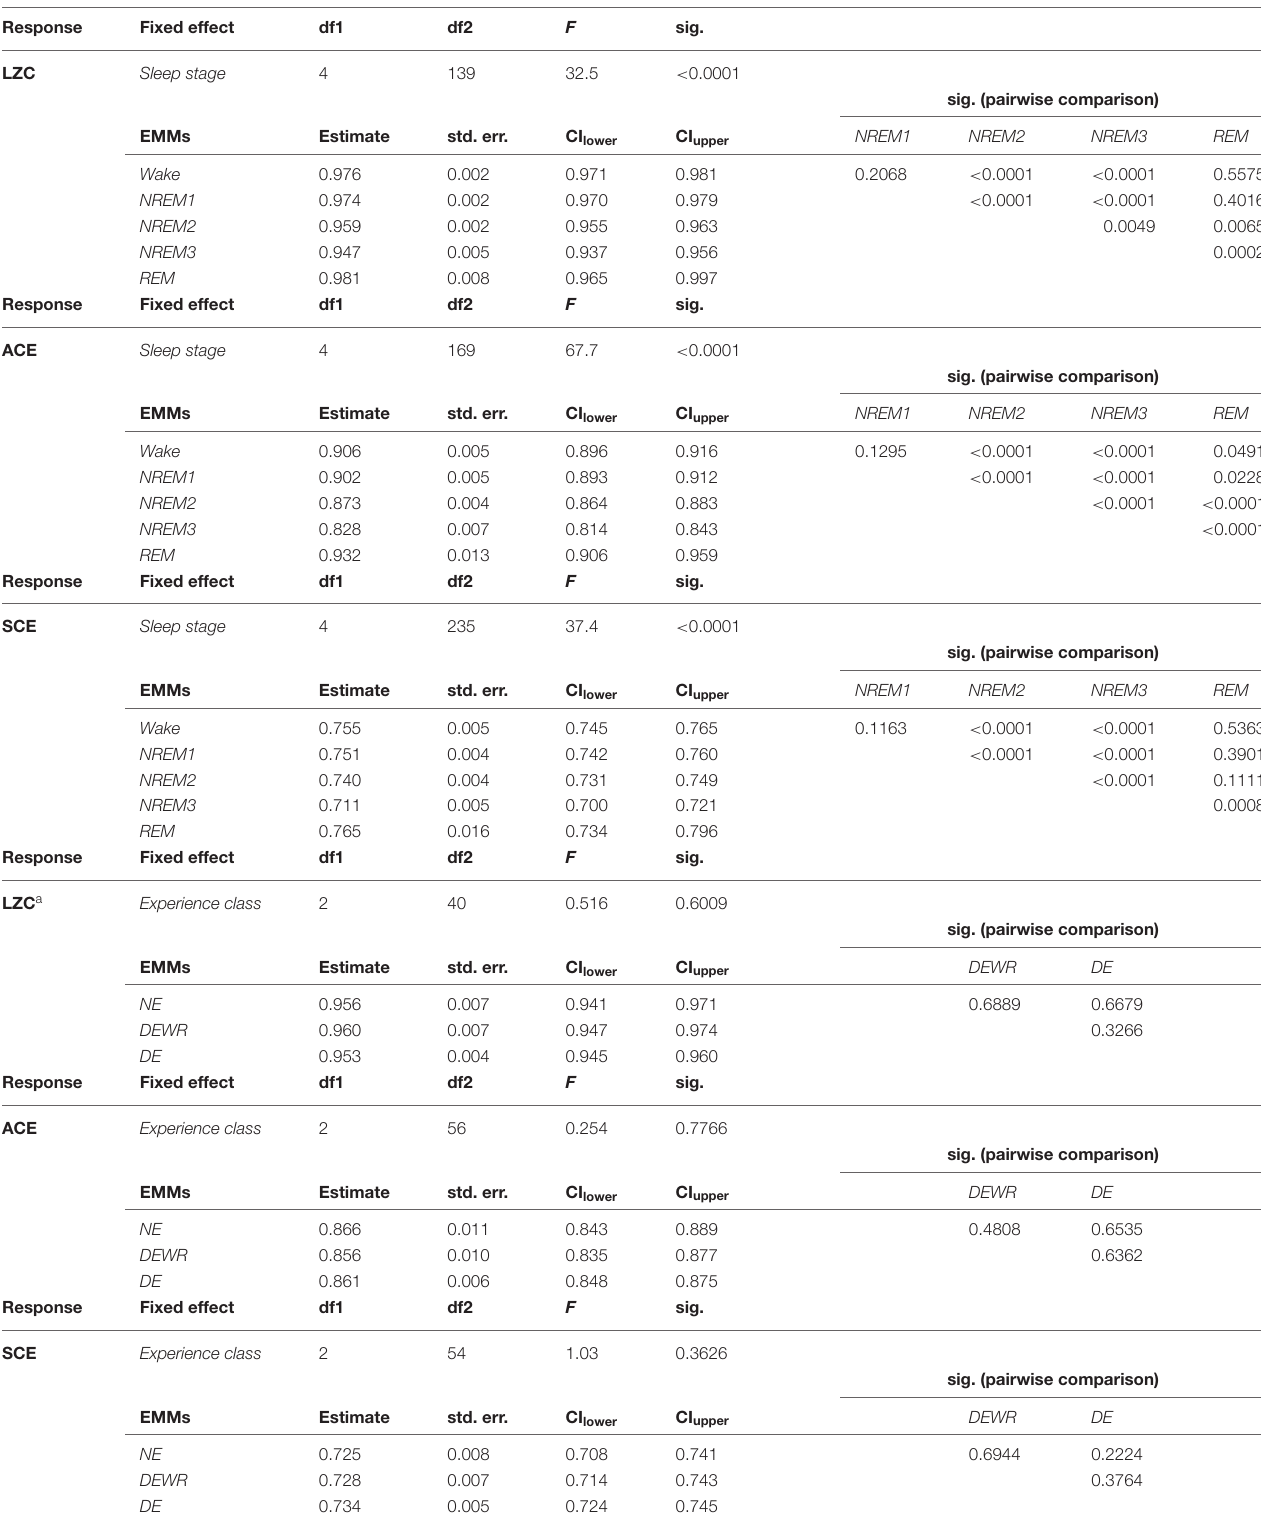
TABLE 1 | Summary of